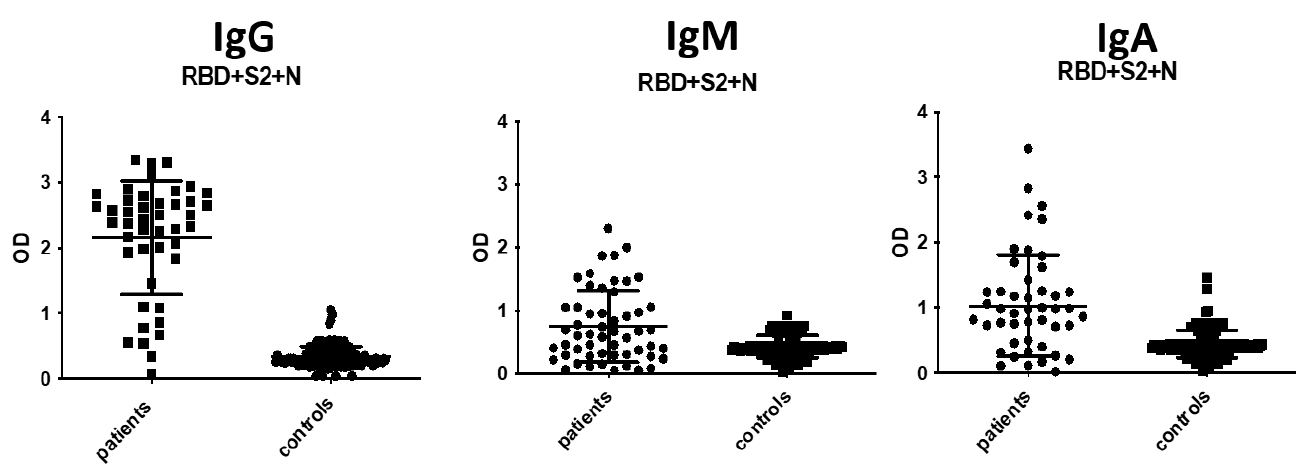
Figure 6. Immunoreactivity of patients’ and controls’ sera against RBD + S2 + N combination for the three different antibody isotypes. Sera were used at a dilution of 1:100, whereas the combination of the 3 different proteins contained RBD, S2 and N proteins at concentrations of 2.5μg/mL, 1μg/mL and N 1.5μg/mL, respectively. The cut-off value for each group was determined using the mean optical density plus 2 SDs of controls. Black symbols represent the Optical Density (OD) value of each serum at 405 nm.